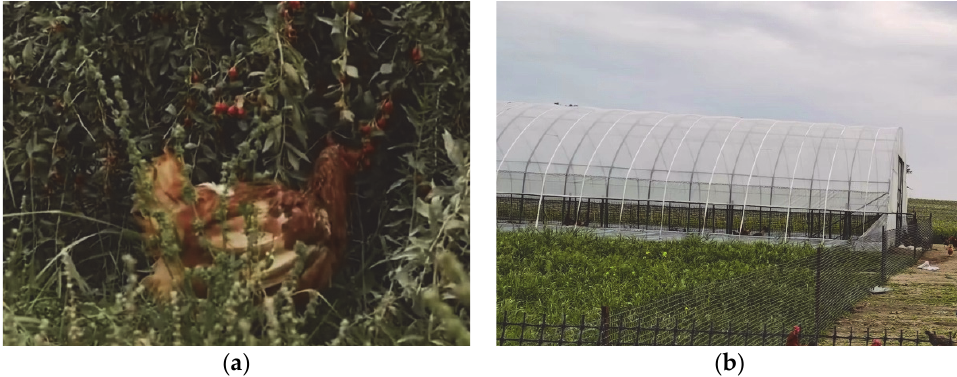
Figure 4. Raising laying hens in a wolfberry forest. ( a ) Native laying hens in the wolfberry plantation. ( b ) A polytunnel shed. Note: ( a ) from China Network Television (CNTV): https://tv.cctv.com/2014/09/11/VIDE1410371397626890.shtml (accessed on 6 August 2022); ( b ) taken by Shaocong Yan.